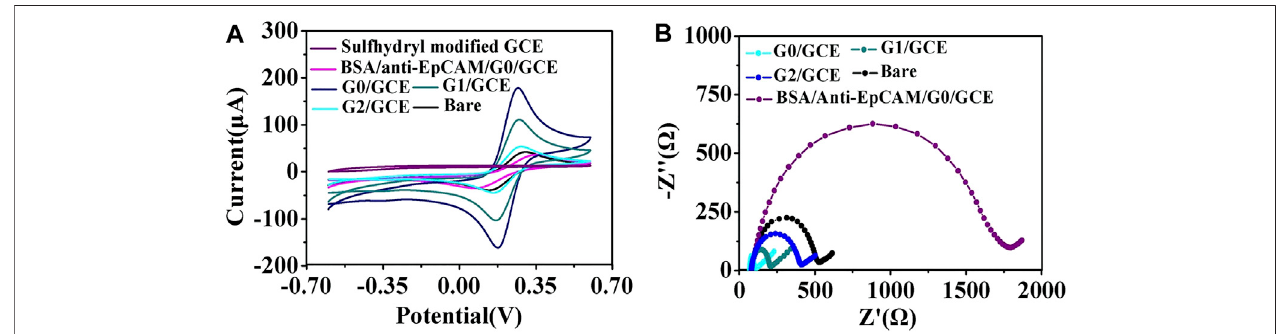
FIGURE 3 | CV of the AuNP/GCE electrodes at different scan rates: 50, 100, 150, 200, 250, and 300 mV/s. (A) G0/GCE, (B) G1/GCE, (C) G2/GCE, (D) Randles – Sevcik plots of G0/GCE, G1/GCE, and G2/GCE electrodes.